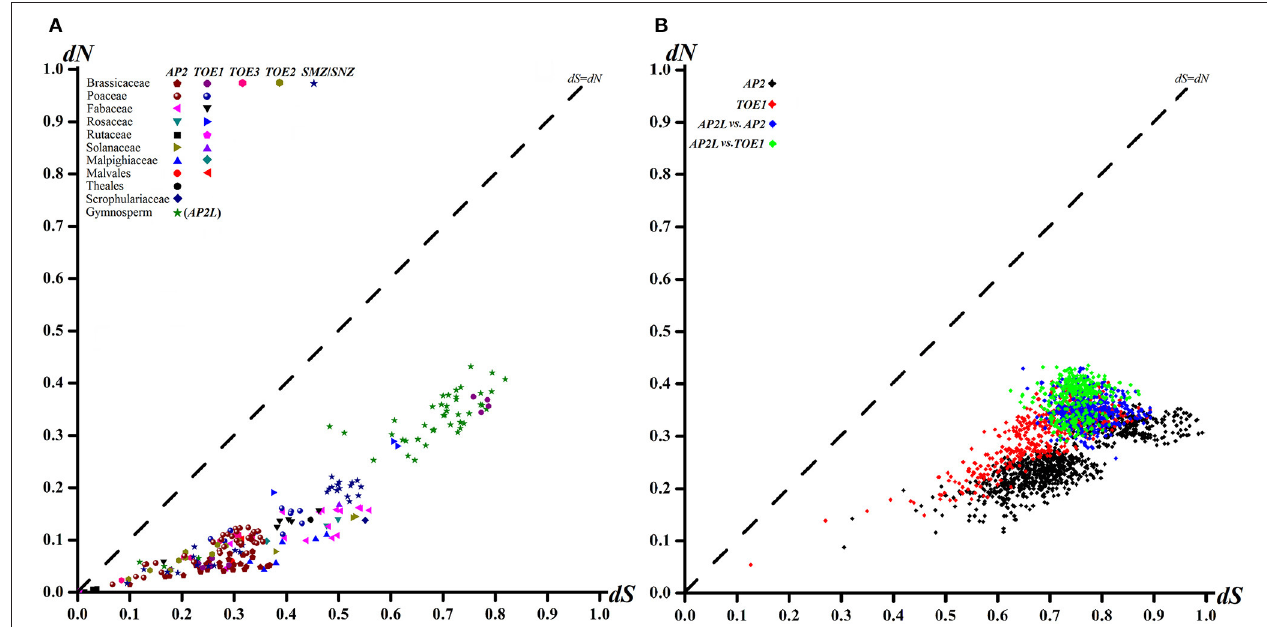
FIGURE 3 | Pairwise Comparison Plots of dN and dS Values for each family (order) AP2 group genes (A) and different clades (B).